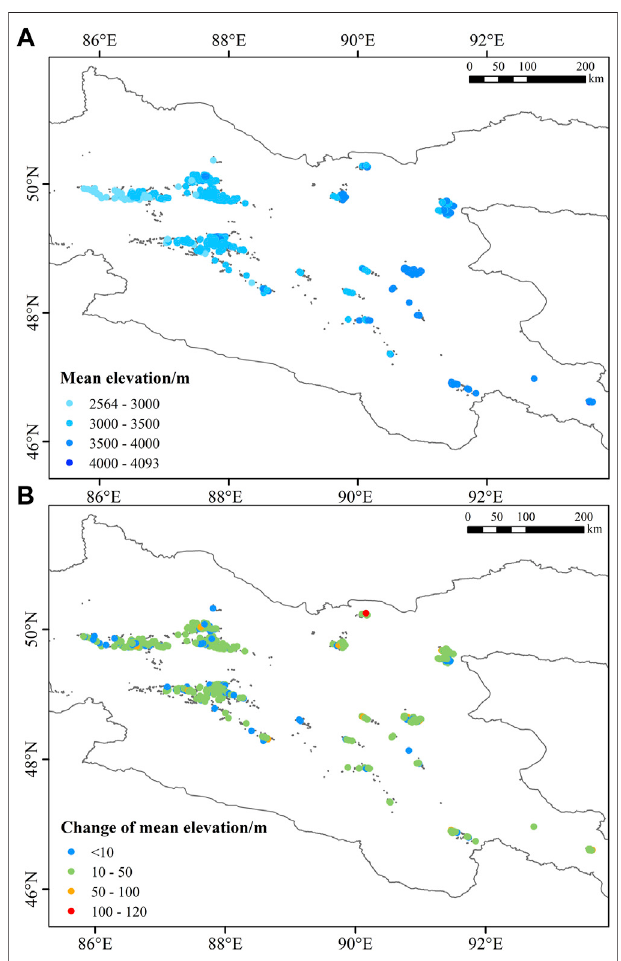
FIGURE 8 | (A) Spatial distribution of mean elevation for glaciers larger than 0.5 km 2 in 2020. (B) Change of mean elevation for glaciers larger than 0.5 km 2 during 2000 –